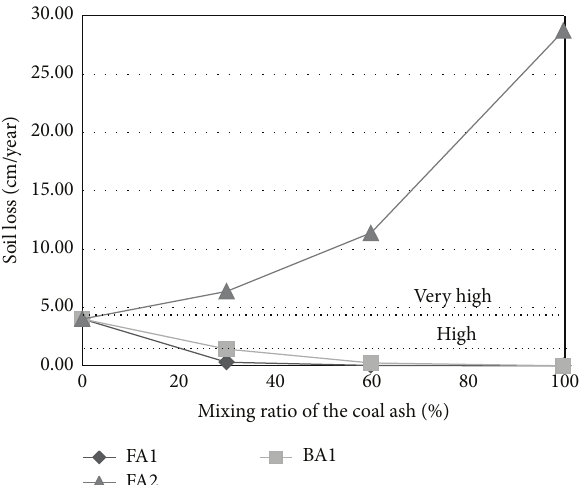
Figure9:Watercontentofthesimulatedtopsoilmixedwiththecoal ash at the mixing ratio of 0%, 30%, 60%, and 100% in the artificial rainfall